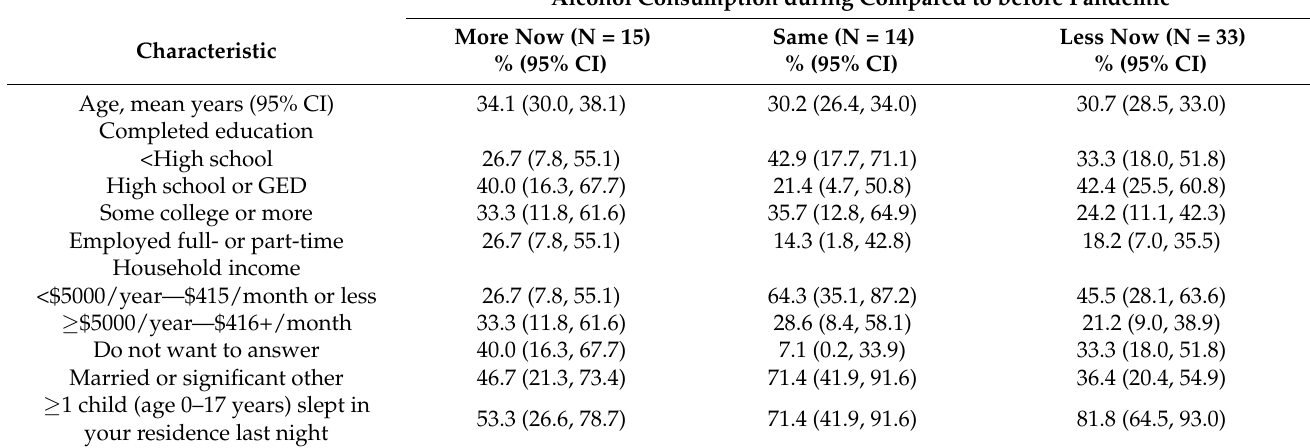
Table 3. Select baseline sociodemographic characteristics for American Indian participants of the NCARE CHOICES study who completed a COVID-19 supplemental questionnaire, according to drinking behavior during the